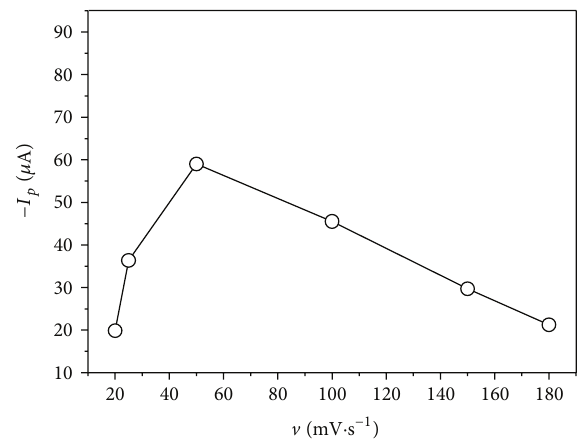
Figure 5: The influence of modified electrodes on 1.0 × 10 −4 mol/L hydroquinone peak current.